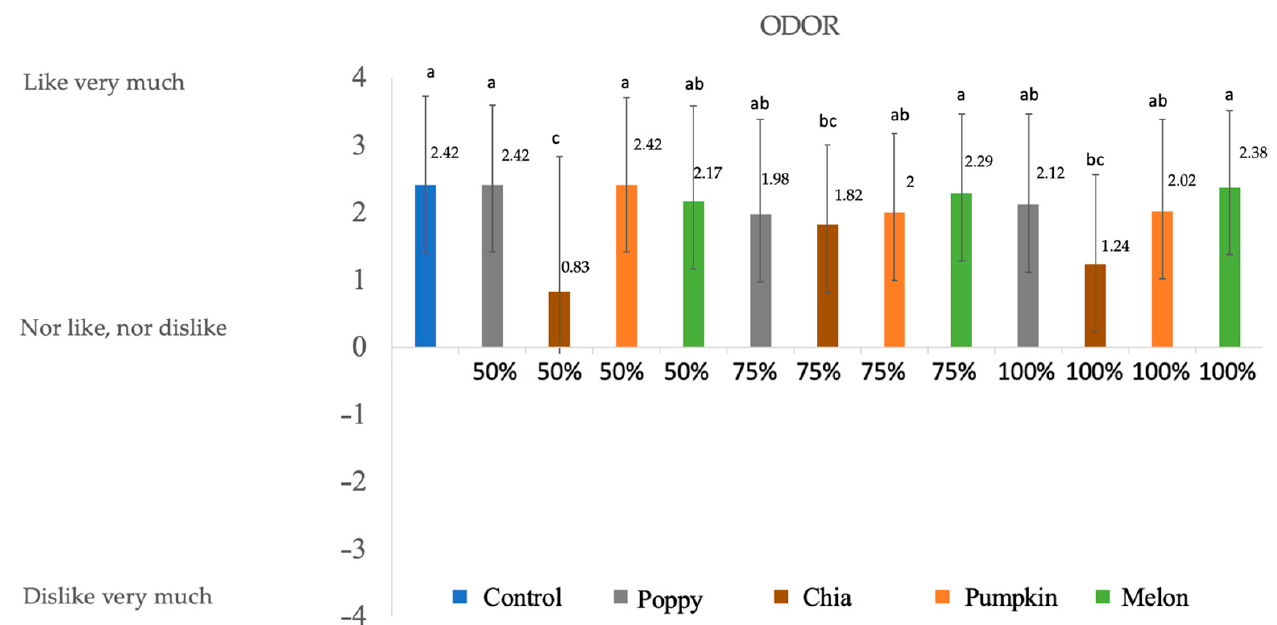
Figure 4. Results obtained in the sensory evaluation for odor. Numbers are mean ± standard error. Different letters in the same column for each attribute indicate statically differences ( p < 0.05).